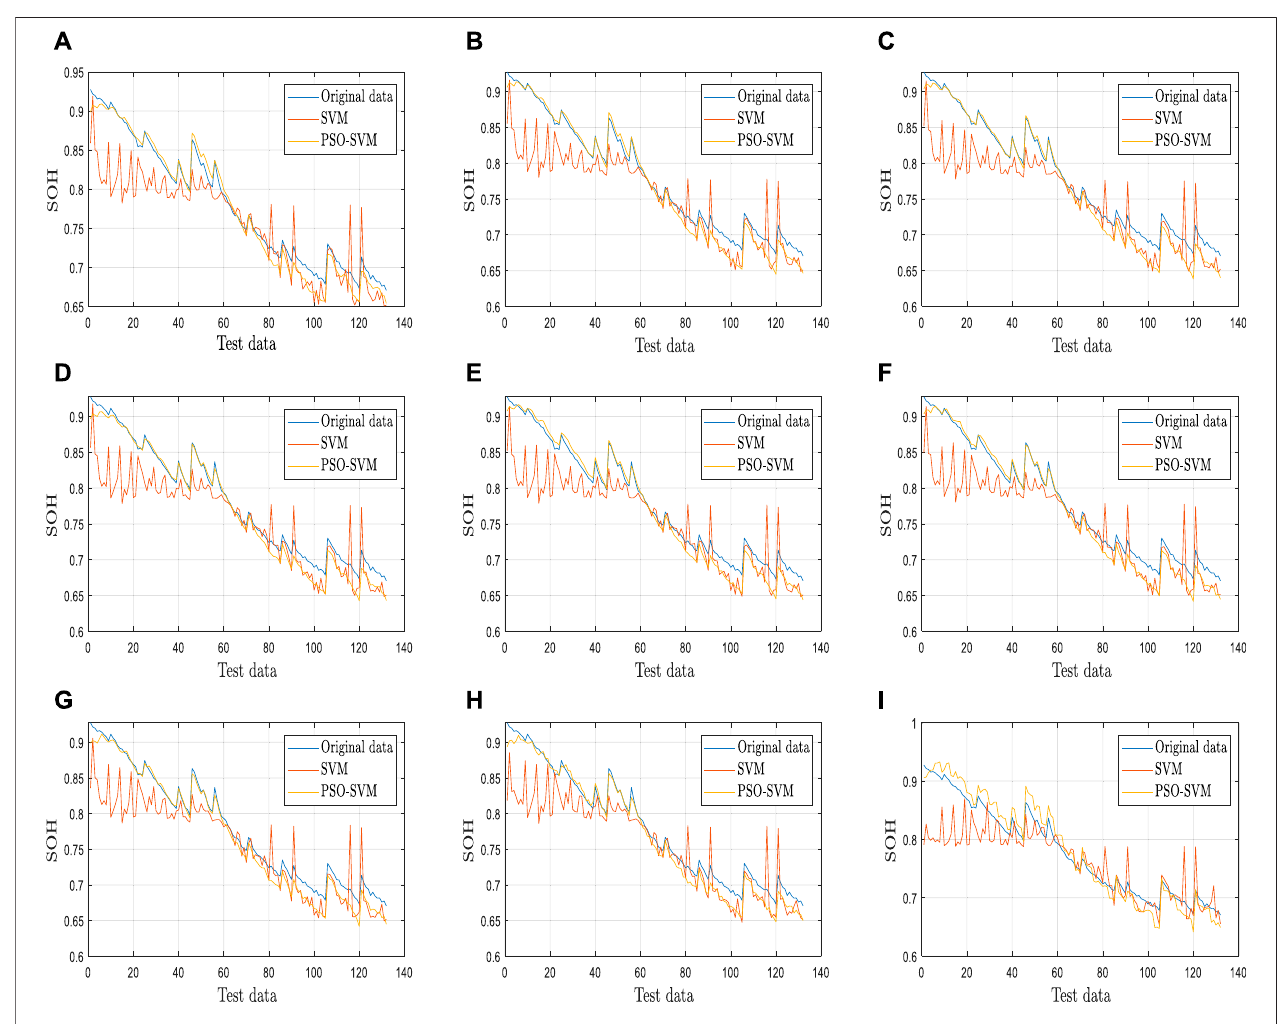
FIGURE 18 | Estimation of SOH in different states of charge (A) SOC change (100 – 10%), (B) SOC change (100 – 20%), (C) SOC change (100 – 30%), (D) SOC change (100 – 40%), (E) SOC change (100 – 50%), (F) SOC change (100 – 60%), (G) SOC change (100 – 70%), (H) SOC change (100 – 80%), (I) SOC change (100 – 90%).